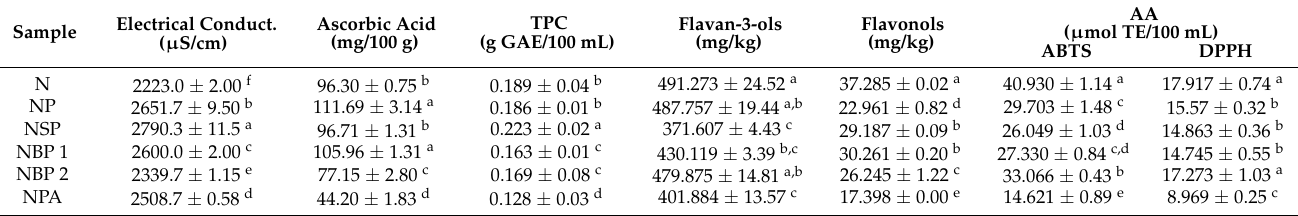
Table 3. Physicochemical parameters and antioxidant activity of different nectar formulations.